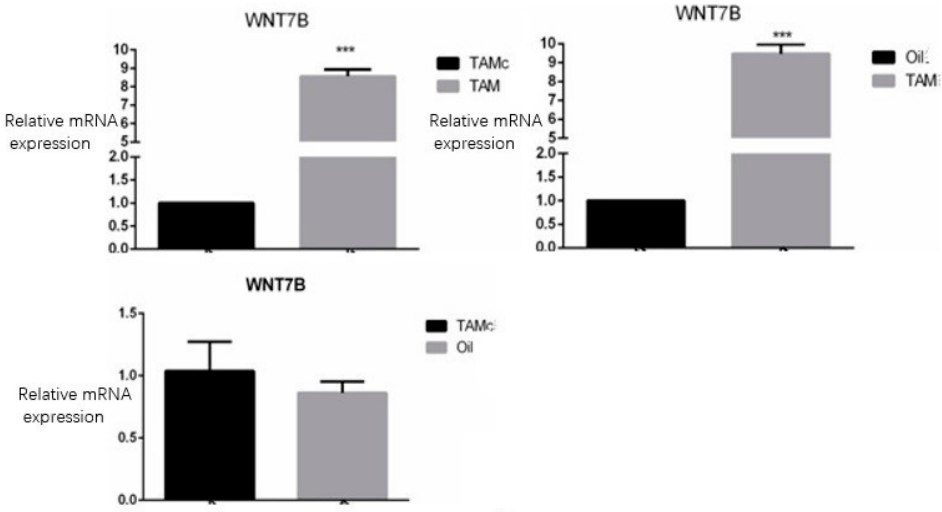
Figure 3. Wnt7b expression level between groups. The expression of Wnt7b in the TAM group is significantly higher than that in the Oil group ( p < 0.01), and Wnt7b expression in the TAM group is significantly higher than that in the TAMc group ( p < 0.01). *** means p < 0.01.